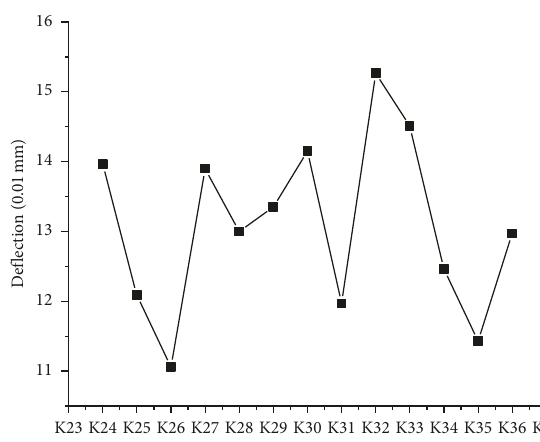
Figure 4: Trend of pavement deflection in